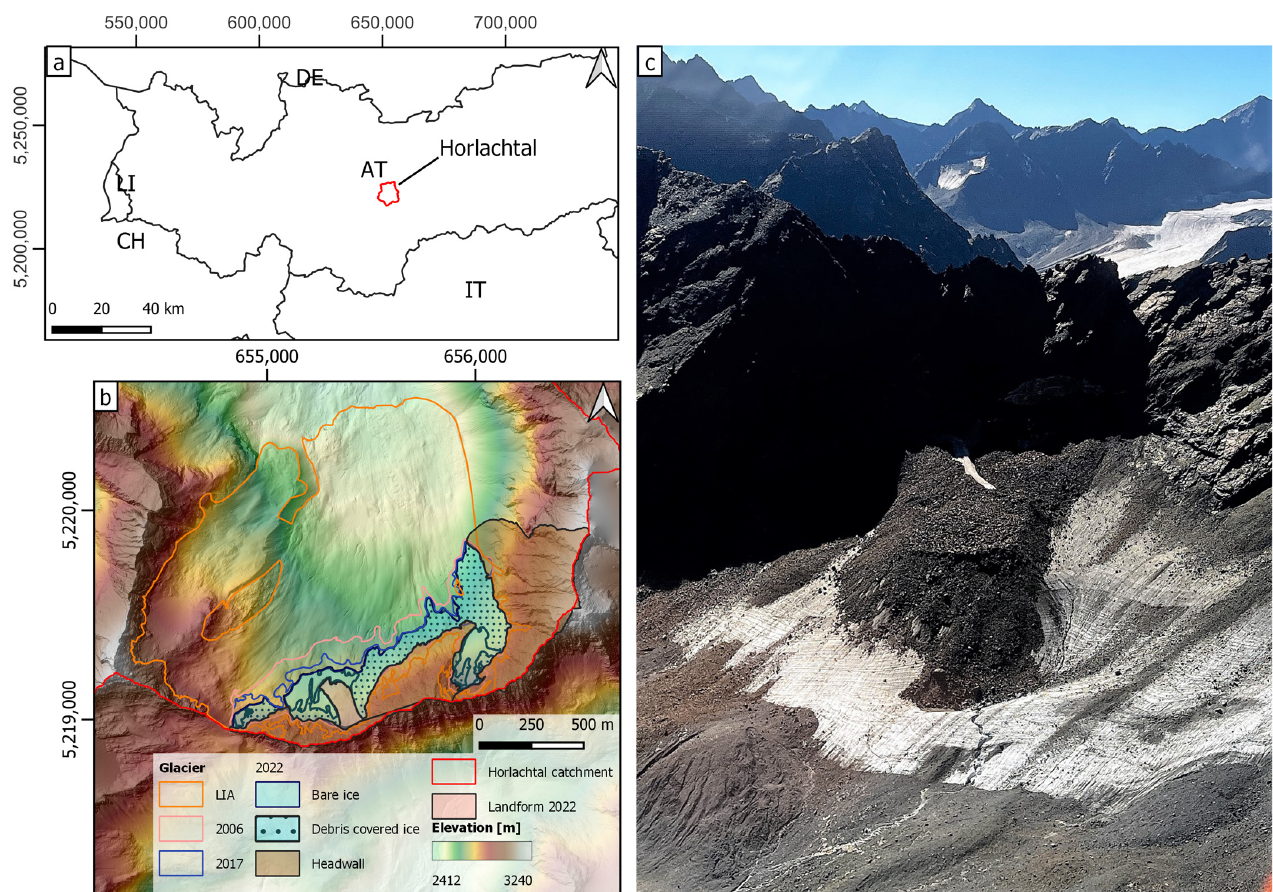
Figure 1. ( a ) Location of the Horlachtal in Austria and surrounding countries. The coordinates in this figure, as well as in all following figures of this study, are ETRS89/UTM zone 32N coordinates (EPSG: 25832). ( b ) Overview map of the study area in Zwieselbachtal. The mapping of glacier extents, glacier headwall, and landform is described in more detail in Section 2.3. The LIA glacier extent is taken from the Austrian Glacier Inventories [40]. ( c ) Aerial photo of the landform, whose development is being studied, taken during the ALS campaign on 03 August 2022.